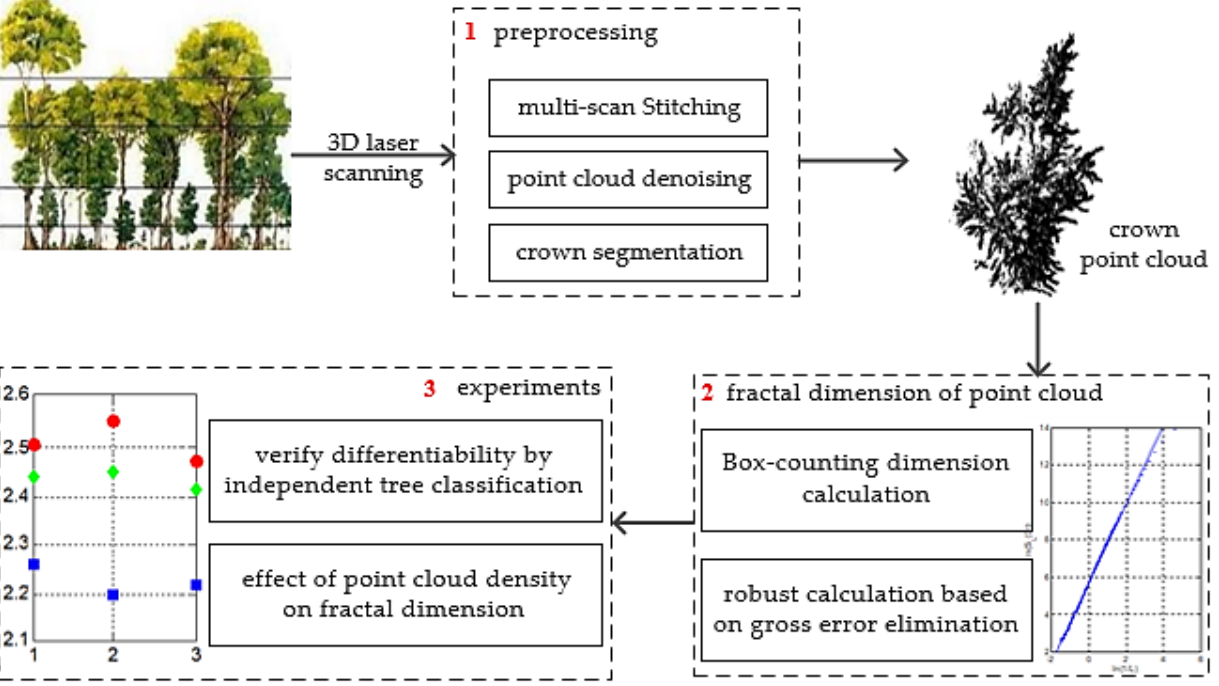
Figure 1. Proposed technique workflow for independent tree species classification based on fractal dimension of dense terrestrial laser point